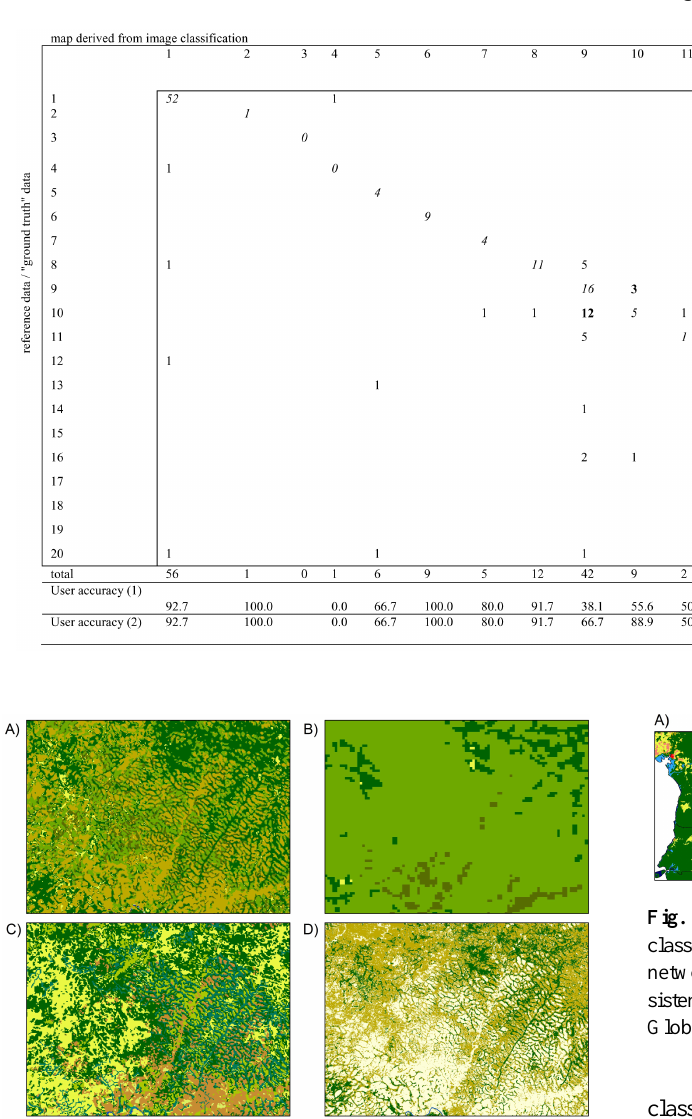
Table 4. Confusion matrix that consider the product and the validation dataset. Italic cells are cells that show agreement between classification and validation (1). Bold cells show cells that have been considered to show agreement (2).